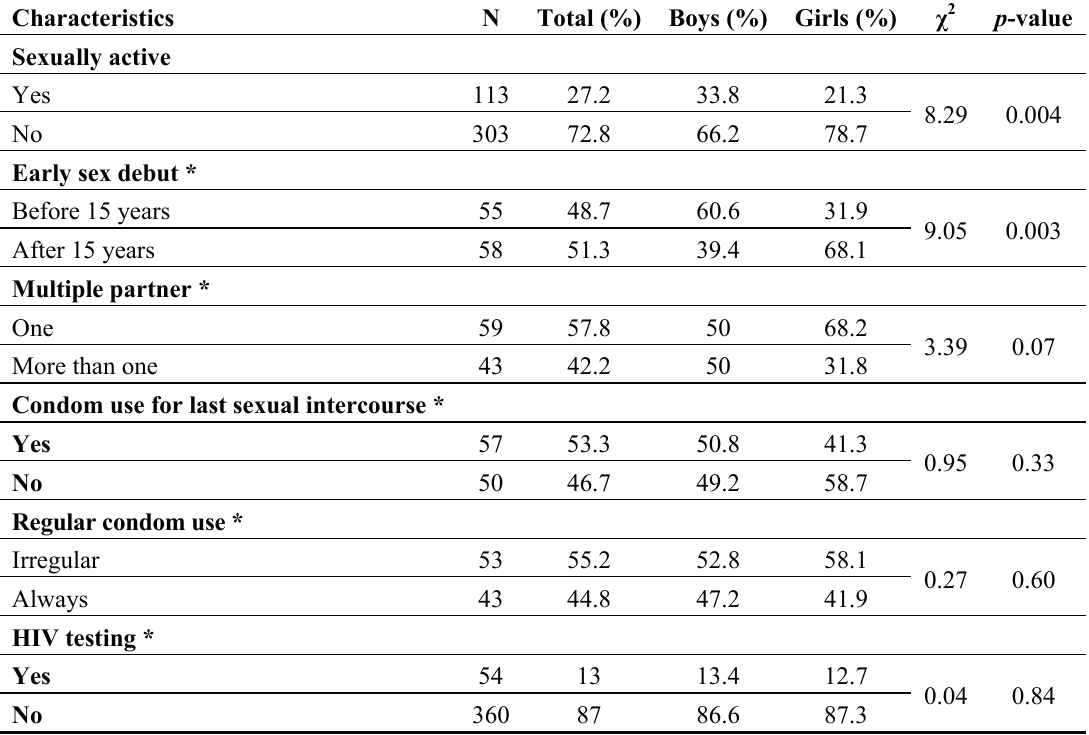
Table 3. Sexual behavior characteristics among the learners.